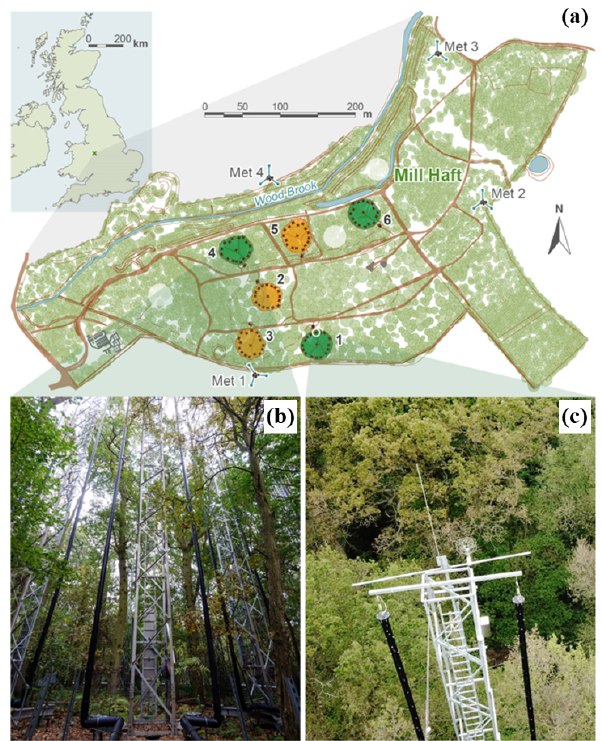
Figure 1. (a) Schematic of the Birmingham Institute of Forest Re- search free-air carbon dioxide enrichment (BIFoR FACE) facility (see Sect. 2.1 for site description). The coloured circles indicate the location of the FACE arrays, with green and orange denoting the fumigated and control arrays, respectively. The grey translucent circles mark the locations of the ghost arrays. The meteorological towers on the edge of the forest are labelled Met 1–4. (b) The per- forated FACE vent pipes in array 4. (c) The two-dimensional sonic anemometer in array 1 (see Sect. 2.2.2 for details of meteorolog- ical measurements). Figure 1a © Crown copyright and database rights 2021. Ordnance survey (no. 100025252). Figure 1c by An- drew Priest